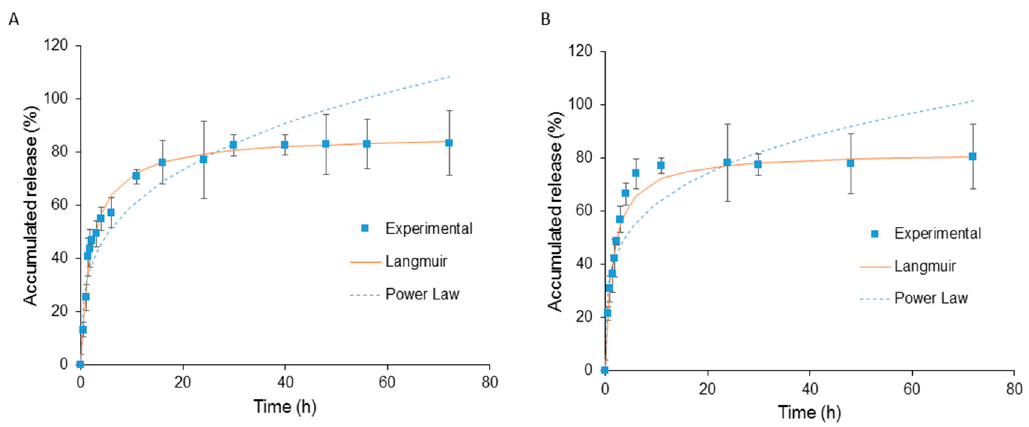
Figure 6. In vitro drug release profile of 5’-DFUR from 5’-DFUR-PCL-MPEG micelles in PBS at 37 °C ( A ) with esterase, ( B ) without esterase (mean ± SD, n = 3).